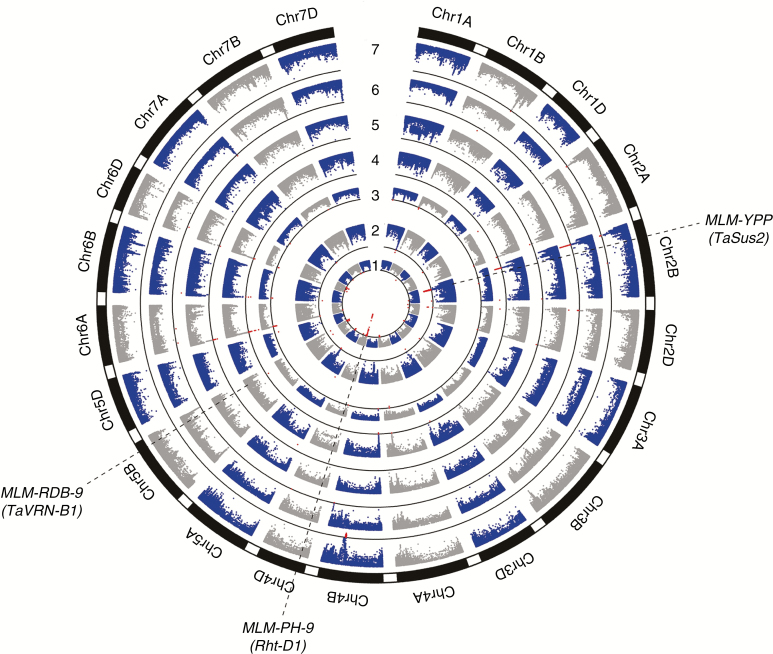
GWAS results for root and shoot traits based on the mixed linear model. Numbers iindicate PH (1, plant height), YPP (2, grain yield per plant), CT (3, canopy temperature), RDB (4, root depth at booting stage), RDG (5, root depth at mid-grain fill stage), RDWB (6, root dry weight at booting stage) and RDWG (7, root dry weight at grain fill stage). Red dots represent significantly associated SNPs, black circular lines indicate the threshold value (P < 1 × 10–4), and the locations of significantly associated loci overlapping reported genes (within parentheses) are shown as black dashed lines.